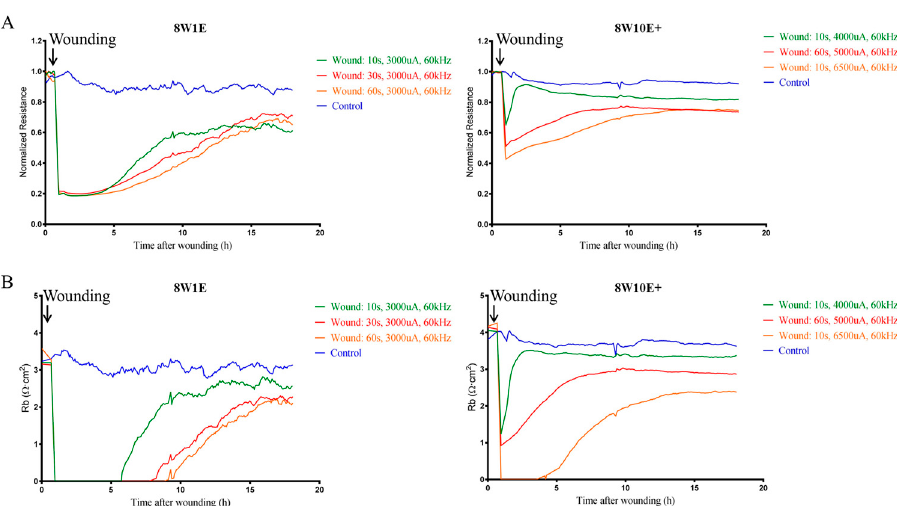
Figure 1. Comparative analysis of real-time endothelial barrier integrity following wounding on the 8W1E and 8W10E+ arrays. ( A ) Time-course of normalized resistance measurements following wounding on the 8W1E and 8W10E+ arrays; ( B ) Time-course of the modelled Rb, the measurement of the endothelial barrier resistance on the 8W1E and 8W10E+ arrays. The hCMVECs were seeded at 0 h at a density of 60,000 cells/cm 2 on both 8W1E and 8W10E+ arrays. Wounding was applied at 48 h post-seeding. Three levels of wounding current are represented by green, red, and yellow lines, respectively. Blue line represents control cells that were not electrically wounded.